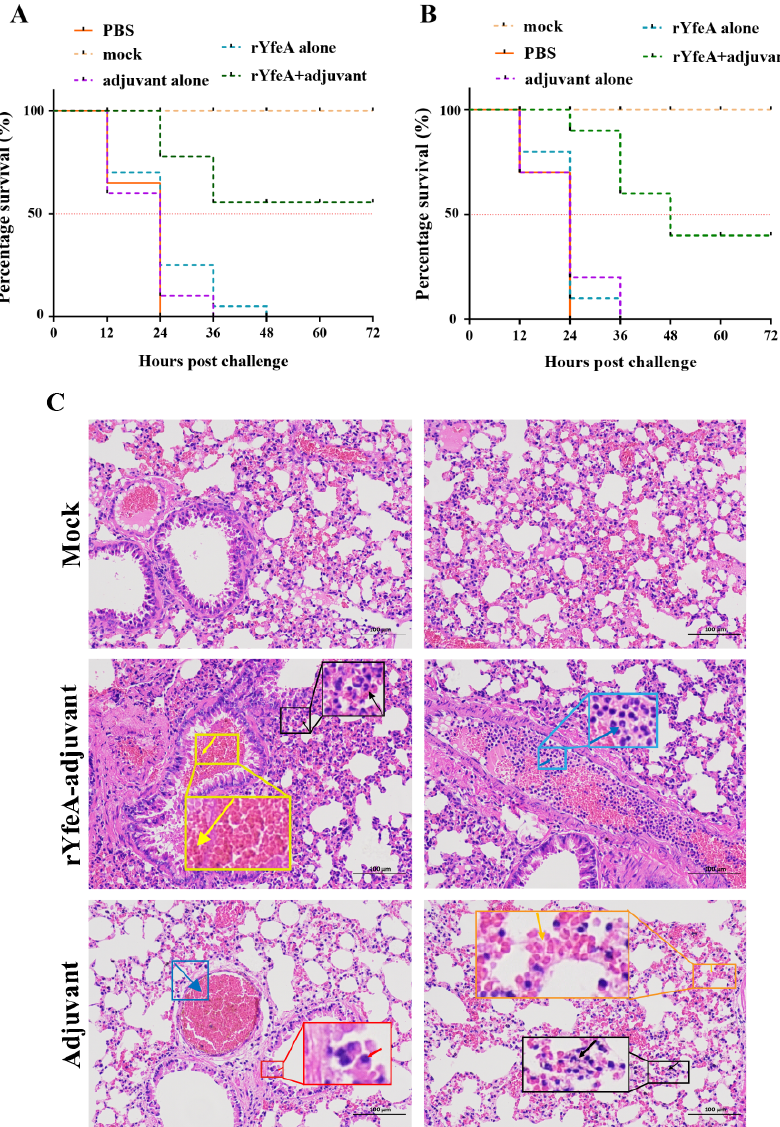
Figure 3. The immunity of rYfeA-vaccinated mice to G. parasuis . The survival rate of C57BL6 mice was challenged with a lethal dose (1 × 10 8 CFU/mouse) of G. parasuis SC1401 ( A , B ). ( A ) In the